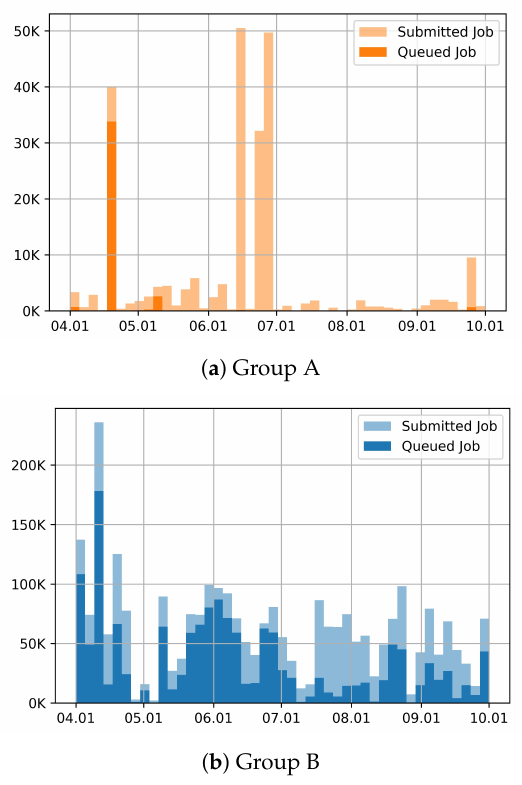
Figure 2. Submitted and queued jobs in